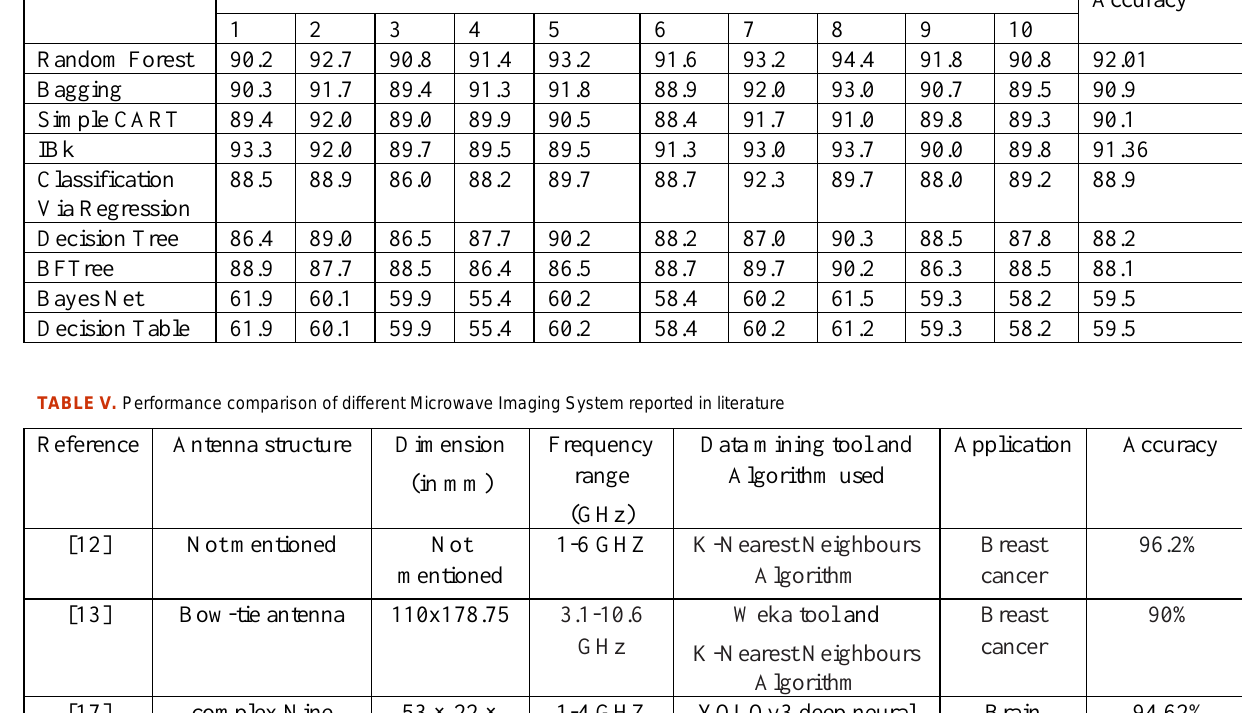
TABLE IV. Results of different Data mining algorithms Algorithm